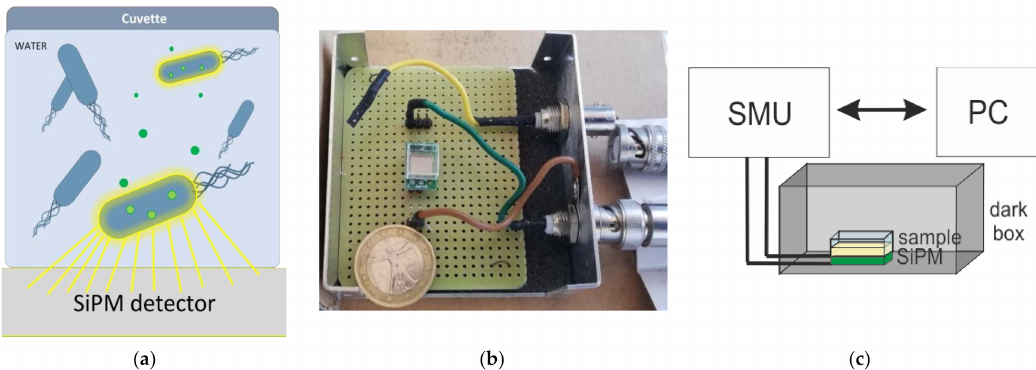
Figure 2. ( a ) schematic of the optical system operation principle based on the Hg 2+ (green circle) uptake by bioluminescent E. coli (blue); ( b ) photograph of the detection site; ( c ) schematic of the optical system configuration, where the SMU is the source meter